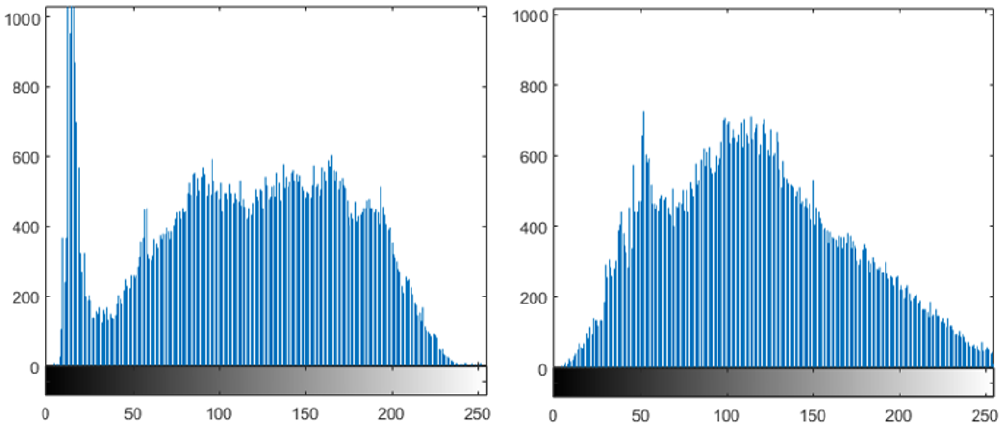
Figure 4. Original image histogram ( left ) and contrast-enhanced image histogram ( right ).